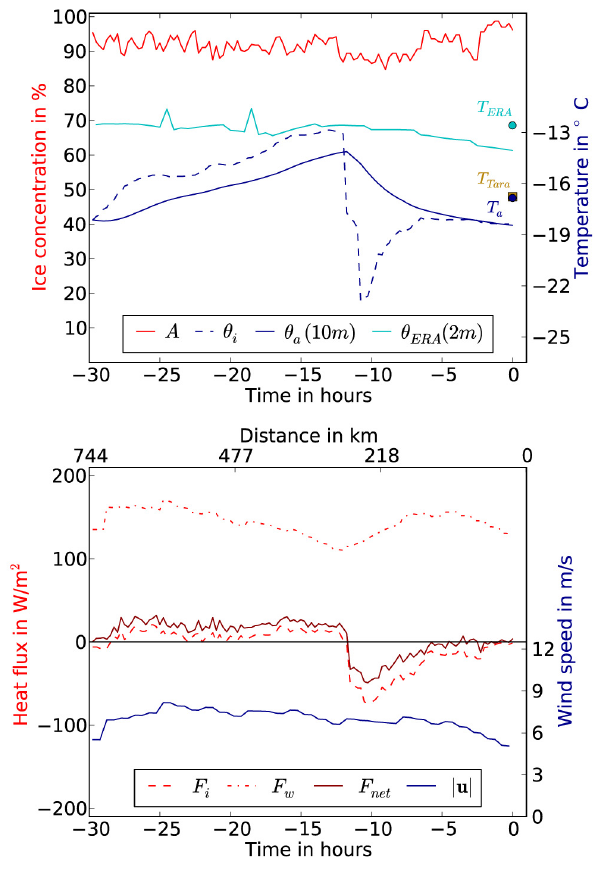
Fig. 5. Time series of the model input and output data on 20 April 2007, 12:00UTC for Tara, AA ice concentration ( A ), ice surface potential temperature ( θ i ), air potential temperature at 10m ( θ a ) (lines) and 2-m air temperature at Tara (symbols) observed and calculated from the predicted 10-m potential temperature, sensible heat flux from ice ( F i ), water ( F w ) and the resulting net flux ( F net ), and ERA surface wind speed ( u ) and 2-m potential temperature ( θ ERA ). The BL depth is 350m. The 2-m air temperature at Tara ( T Tara ) is plotted for comparison.